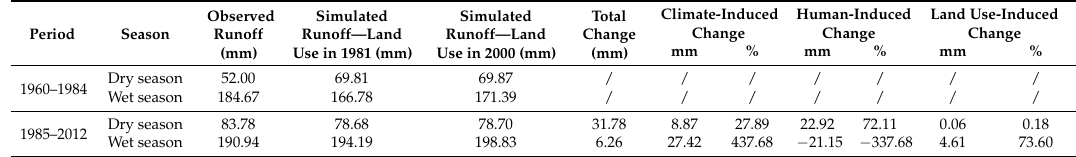
Table 7. Results of attribution analysis for runoff change in the Qingliu River basin on a seasonal scale.